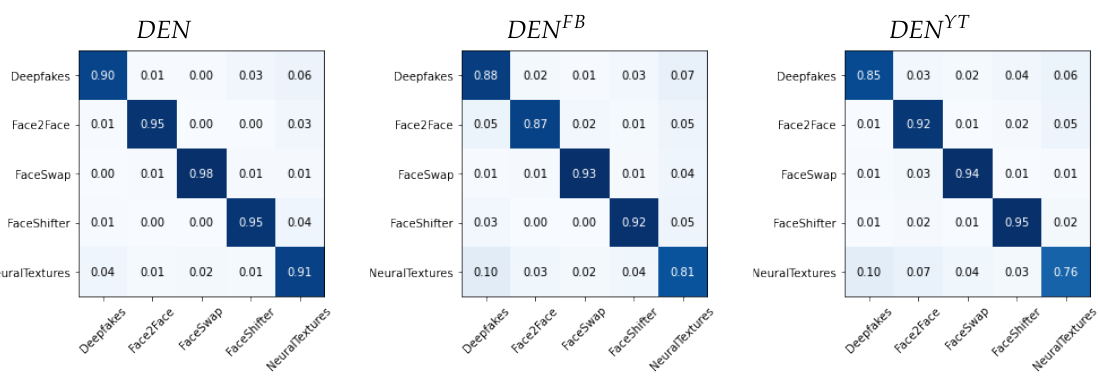
Figure 8. Confusion matrices obtained from DEN ( x ) in the pre-social and post-social